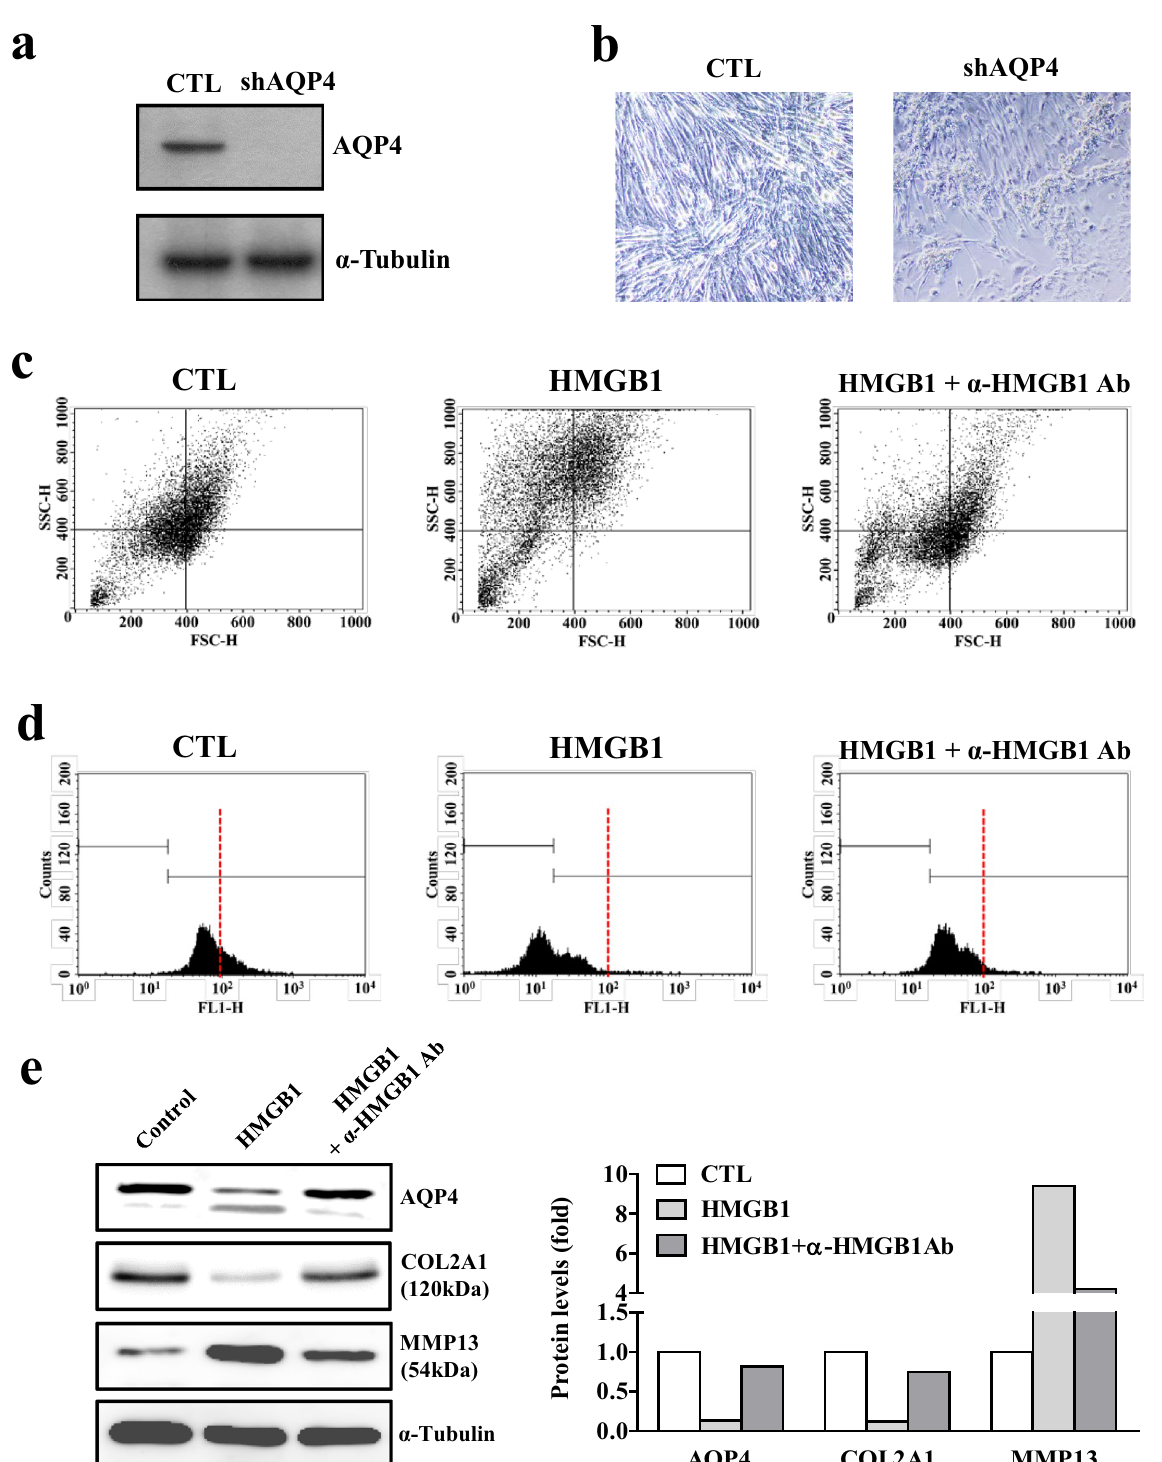
Figure 6. Chondrocyte defects by loss of AQP4 and improvement of HMGB1-induced cell defects by HMGB1 neutralization. ( a ) AQP4 protein expression in AQP4 shRNA-transfected C3H10T1/2 cells. ( b ) Morphology of AQP4 shRNA-transfected chondrogenic C3H10T1/2 cells for 48 h. ( c ) Flow cytometry analysis in HMGB1-treated chondrogenic C3H10T1/2 cells in the presence or absence of HMGB1- antibody (Ab). ( d ) Representative frequency histogram of DiOC6 fluorescence (FL1-H) the showing the mitochondrial membrane potential. ( e ) Western blot analyses for AQP4, COL2A1 and MMP13 protein expression. Densitometric analyses of the western blots are shown on the